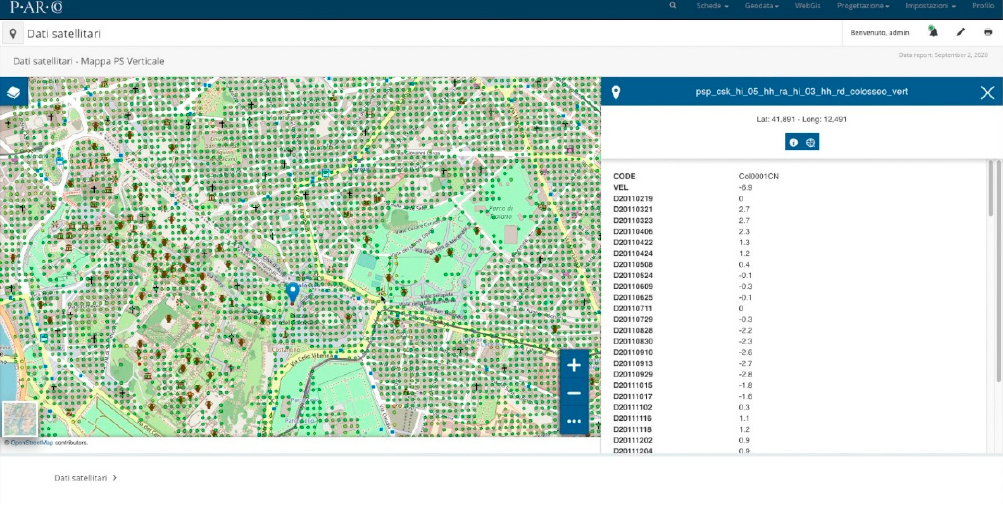
Figure 6. SyPEAH, satellite